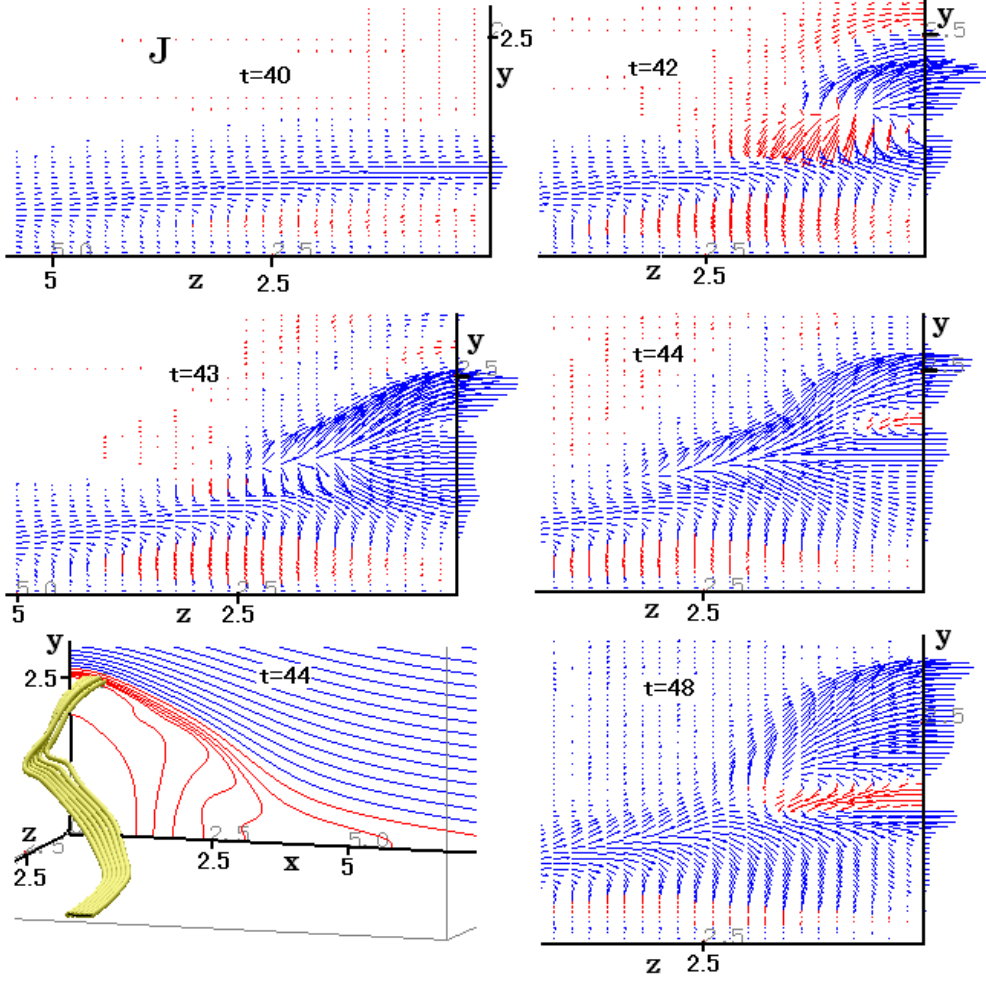
Fig. 9. Current density vectors at different times in the chromosphere ( x = 0). In the left bottom, the current wedge formation is